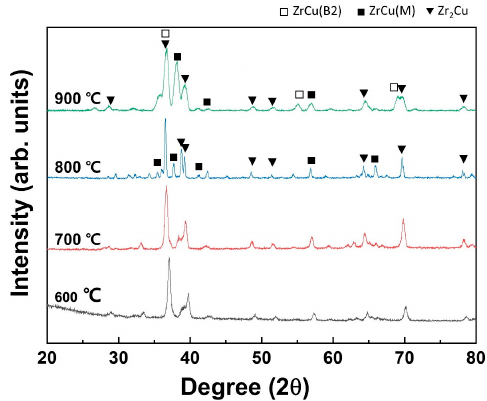
Figure 6. XRD results according to the annealing temperature of the target.